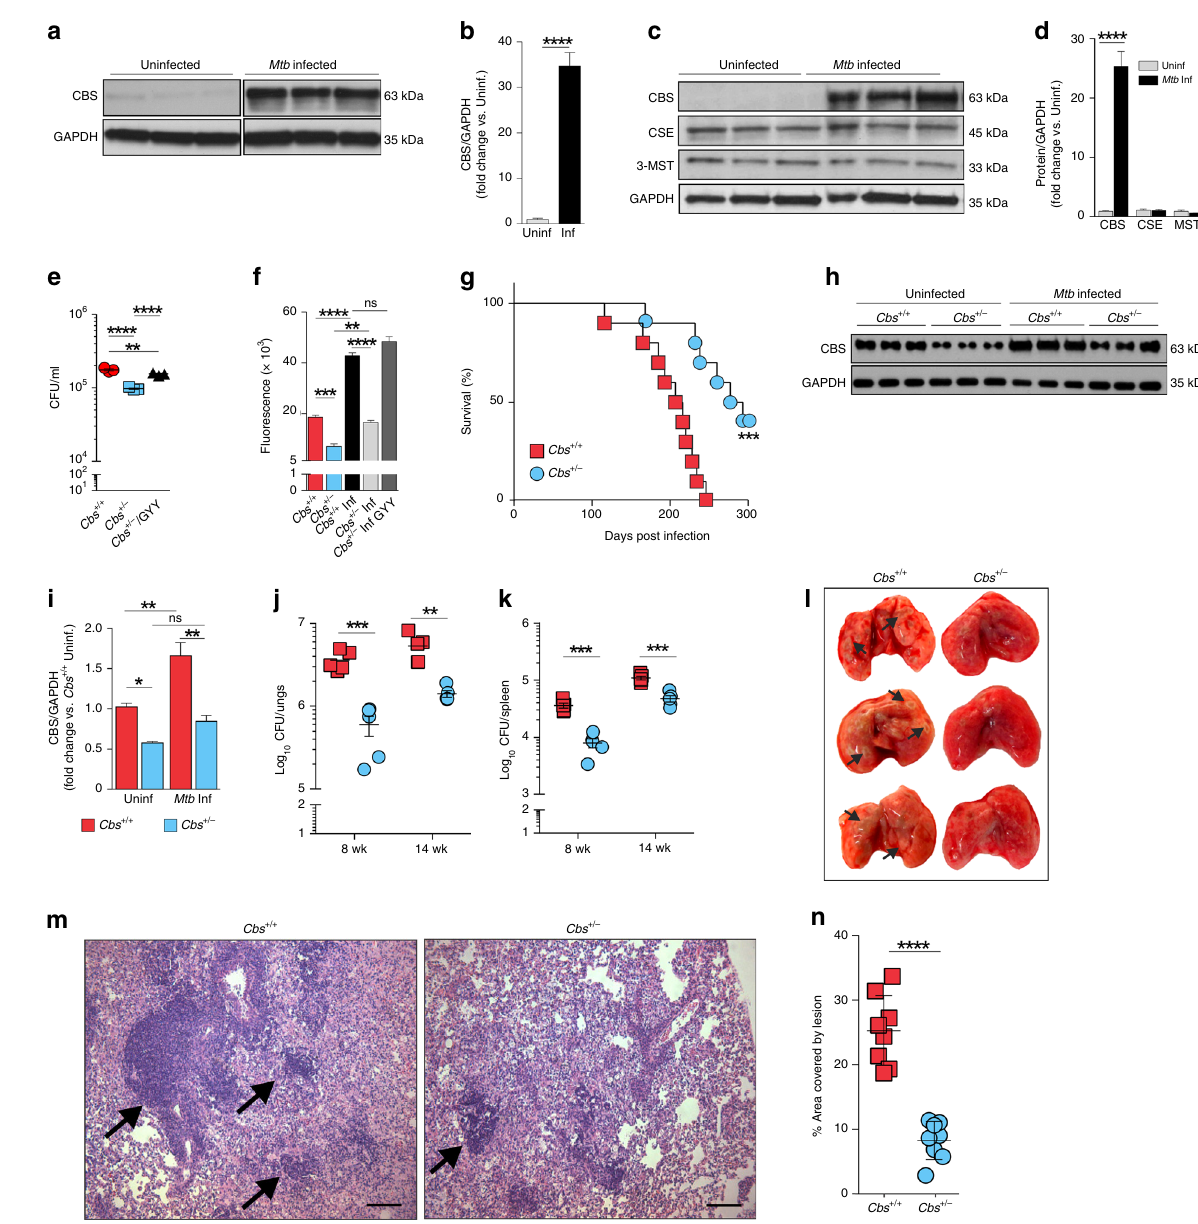
Fig. 1 Attenuation of Mtb virulence and pathogenicity in Cbs + / − mice. a Representative western blot and b densitometry analysis of CBS levels in RAW 264.7 macrophages following 6 h of Mtb infection ( n = 3). c Representative western blot and d densitometry analysis of H 2 S-producing enzymes in WT mouse peritoneal macrophages following 6 h of Mtb infection ( n = 3 animals per group). e CFU recovery from Mtb -infected peritoneal macrophages isolated from WT and Cbs + / − mice at 36 h post infection. f Relative quantitation of H 2 S production from uninfected or infected (Inf) peritoneal macrophages using the H 2 S-speci fi c fl uorescent probe WSP1 28 at 36 h post infection. The Cbs + / − Inf GYY4137 group received 25 µ